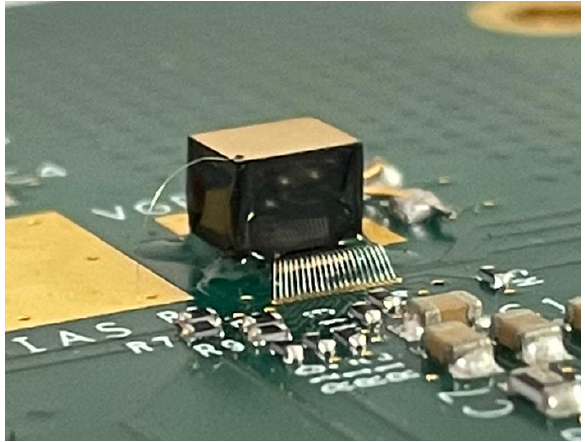
Figure 3. The 3-mm LF-CZT pixel detector flip-chip bonded on the PIXIE ASIC. A bias voltage of − 1800 V was supplied by a gold wire glued on the planar cathode electrode, clearly visible in the picture.